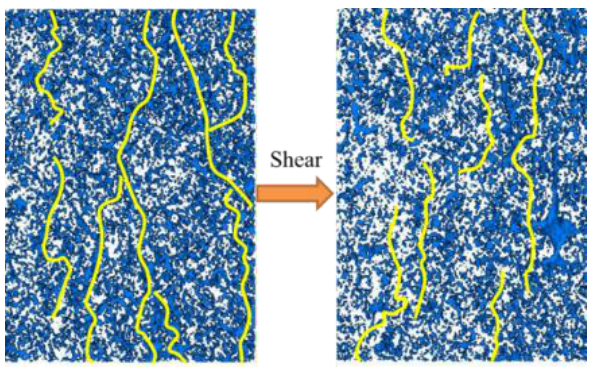
Figure 22. Schematic diagram of the evolution of the seepage channel